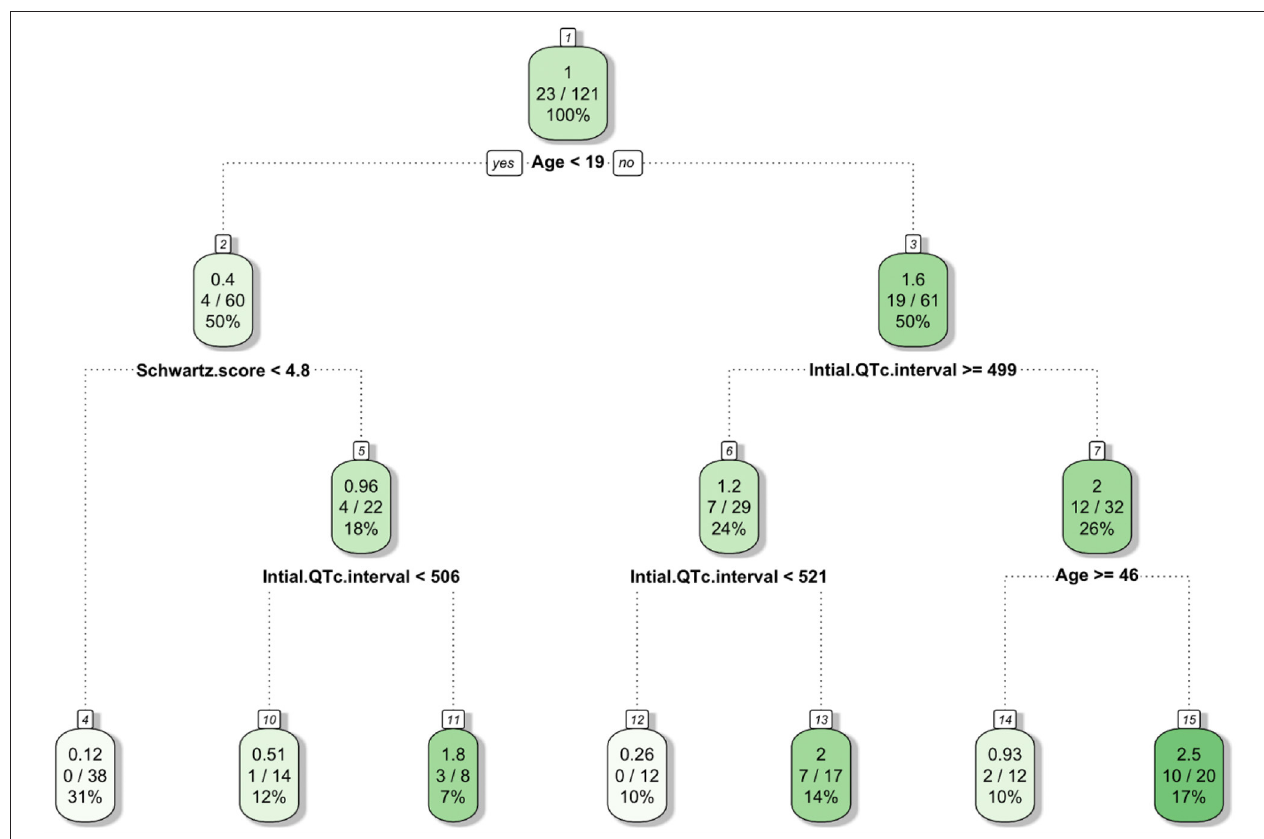
FIGURE 5 | Decision rules generated by RSF model to predict VT/VF